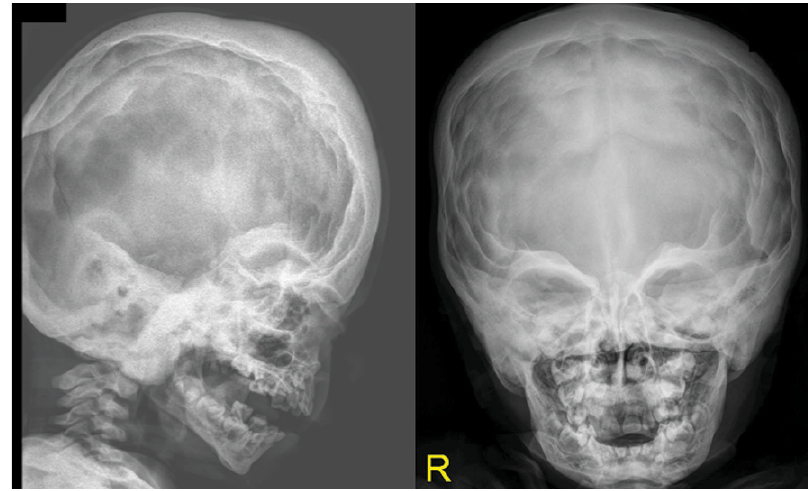
Figure 1 - Lateral skull and AP radiographs show marked cranial osteosclerosis and hyperostosis. The facial bones and base of the skull are severely